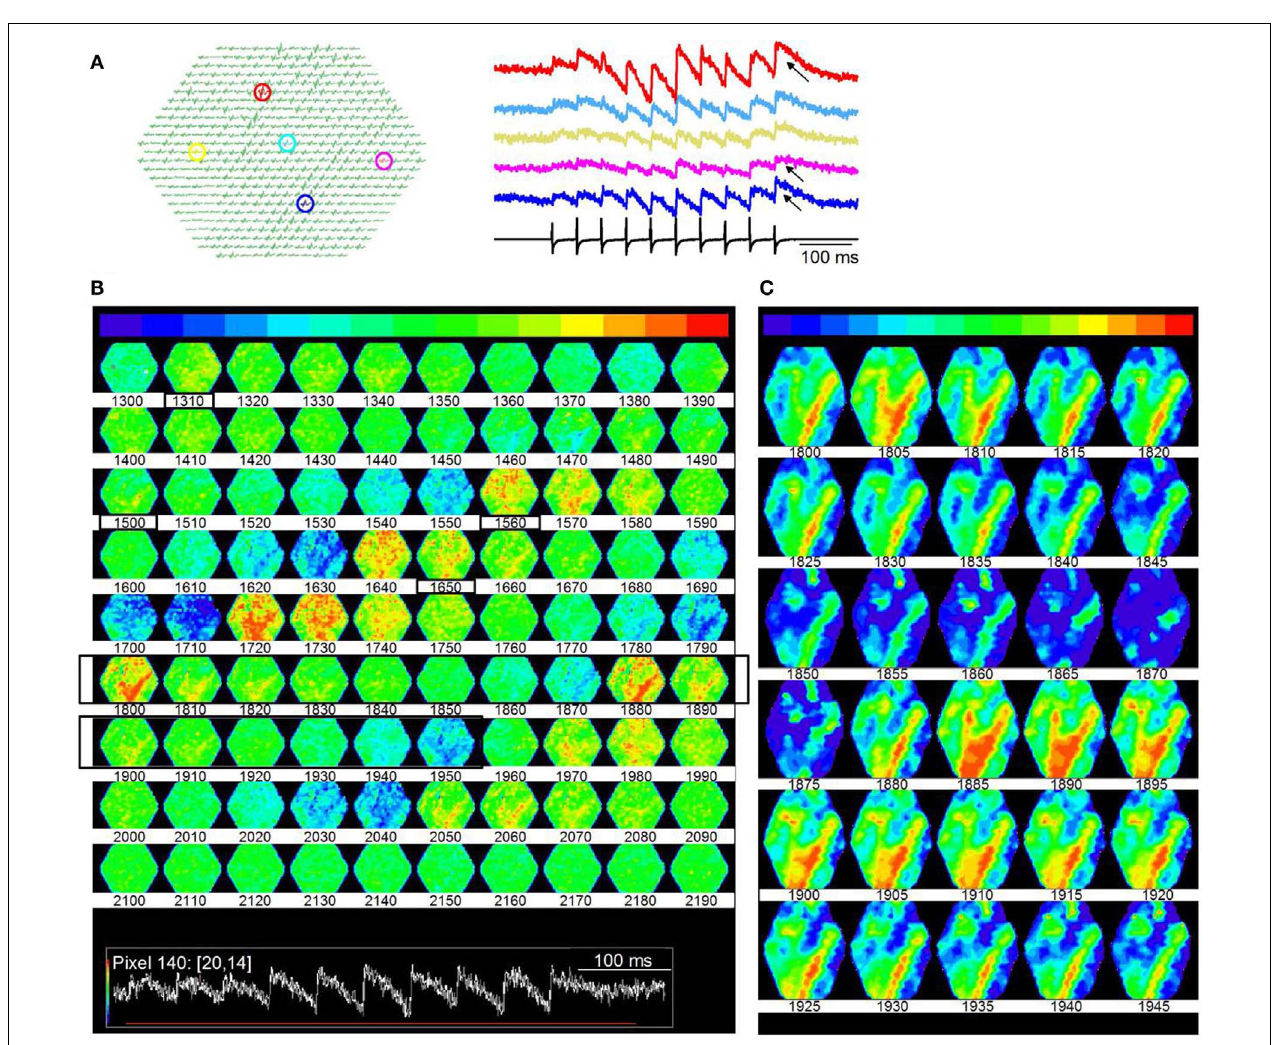
4, 1600–1690; Row 5, 1700–1790; Row 6, 1800–1890; Row 7, 1900–1990; Row 8, 2000–2090; Row 9, 2100–2190. Black boxed region, frames 1800–1850 that are illustrated in (C) . Inset: Red line, region of the response covered by frames 1300–2190. (C) Expansion of black boxed region (frames 1800–1845) in (B) . Frames are 3ms apart.The baseline color in (C) has been changed from green to blue to extend the minimum to maximum color